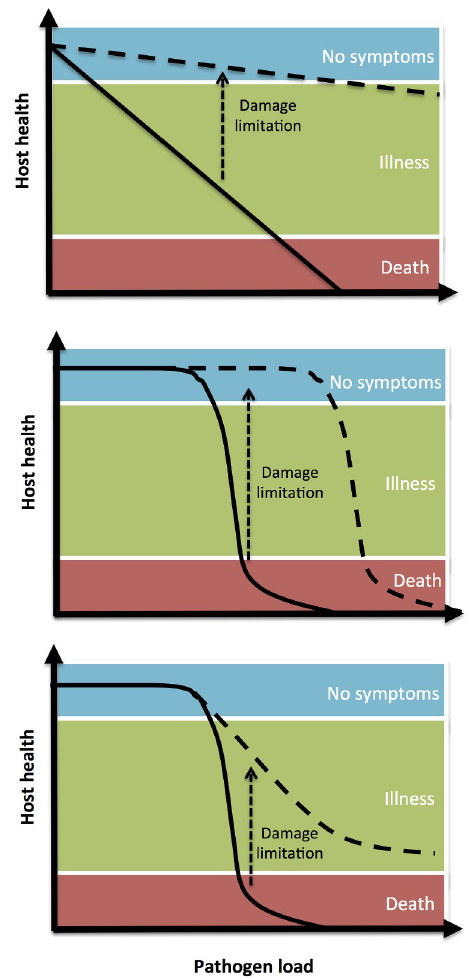
Fig 8. The effect of damage limitation mechanisms on the loss of host health during infection. One can imagine several relationships between increasing pathogen load and host health, which may be infection- or pathogen- specific. Image reproduced under CC-BY 4.0 license, credit: